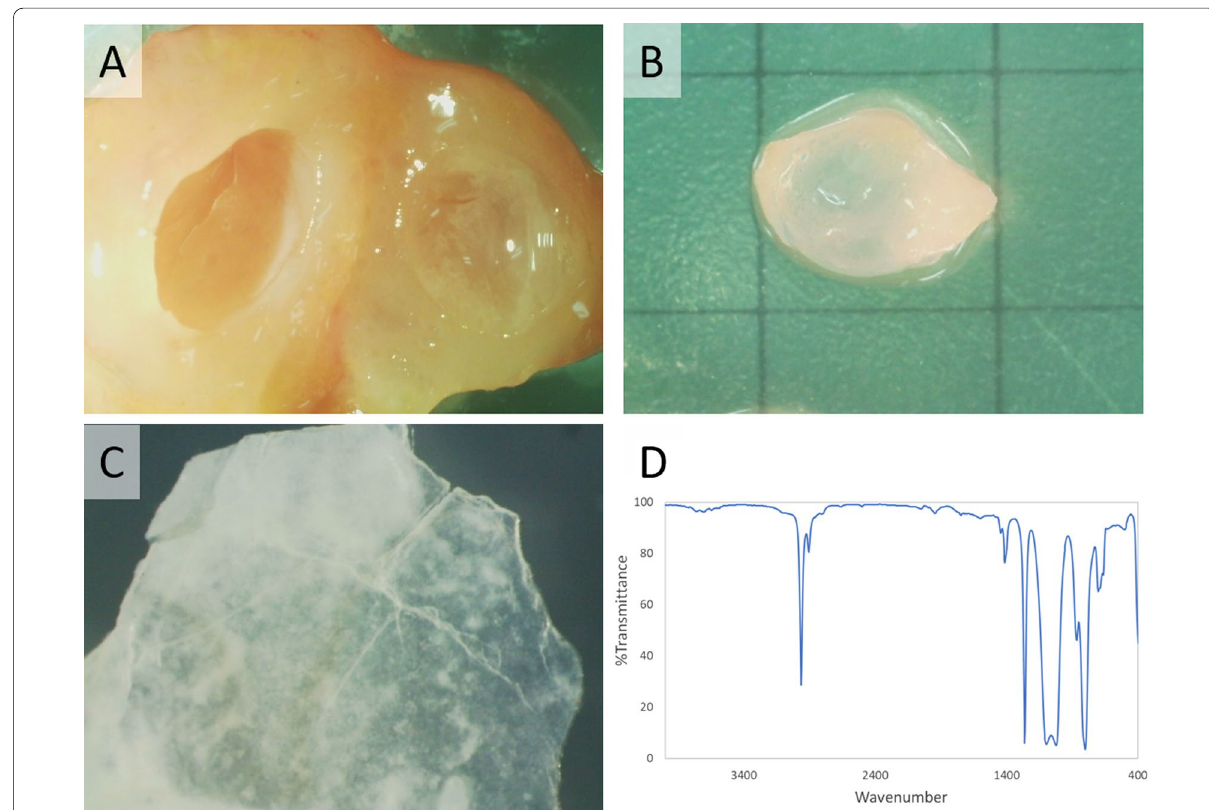
Fig. 4 Analyses of the multiple cysts and their contents. A Multiple cysts with high viscous liquid contents were observed in the removed mammary tissue. B , C Remained cyst wall after protein/lipid digestion. Thin hard shell remained when cysts were placed in a protein/lipid-digesting solution for 2 weeks. D Liquid contents in the cysts were isolated and analyzed by Fourier transform infrared spectrophotometer at the Chemicals Evaluation and Research Institute,